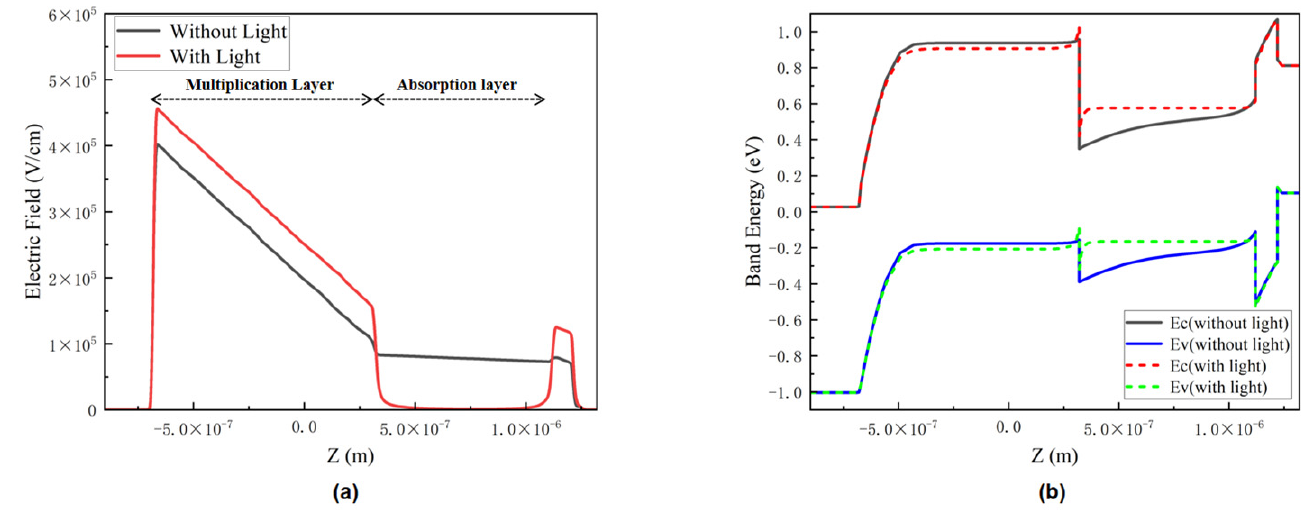
Figure 7. ( a ) Electric field distribution of the original InGaAs/Si APD at the same operating voltage along the vertical direction; ( b ) band structure of the original InGaAs/Si APD at 0